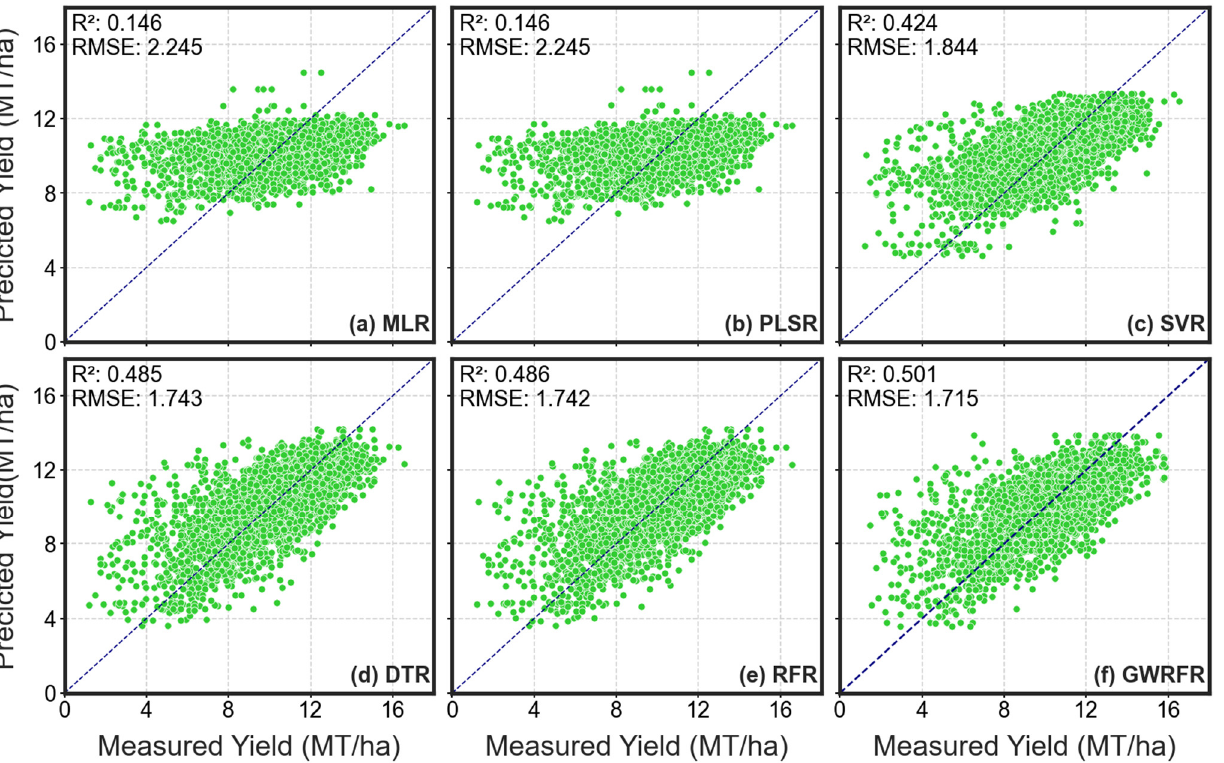
Figure 9. The scatterplots of actual yield and predicted yield derived from ( a ) MLR, ( b ) PLSR, ( c ) SVR, ( d ) DTR, ( e ) RFR, and ( f ) GWRFR using only soil data.